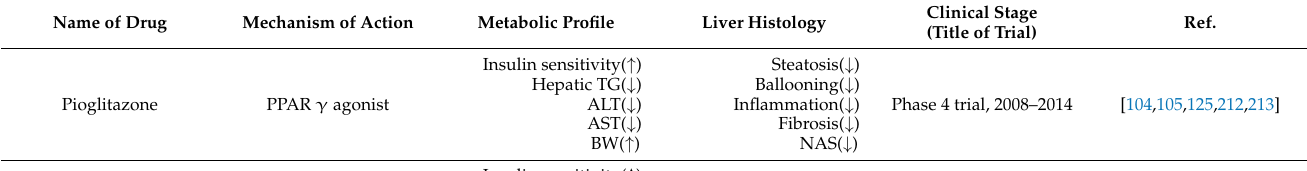
Table 1. Summary of promising drugs for